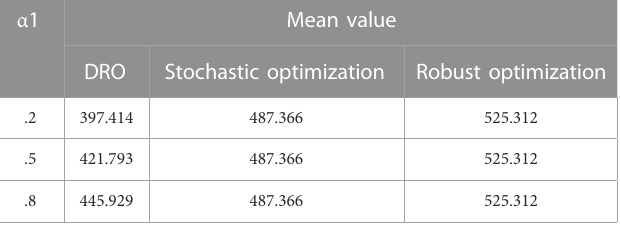
TABLE 9 Comparison of results of different algorithms. α 1 Mean value DRO Stochastic